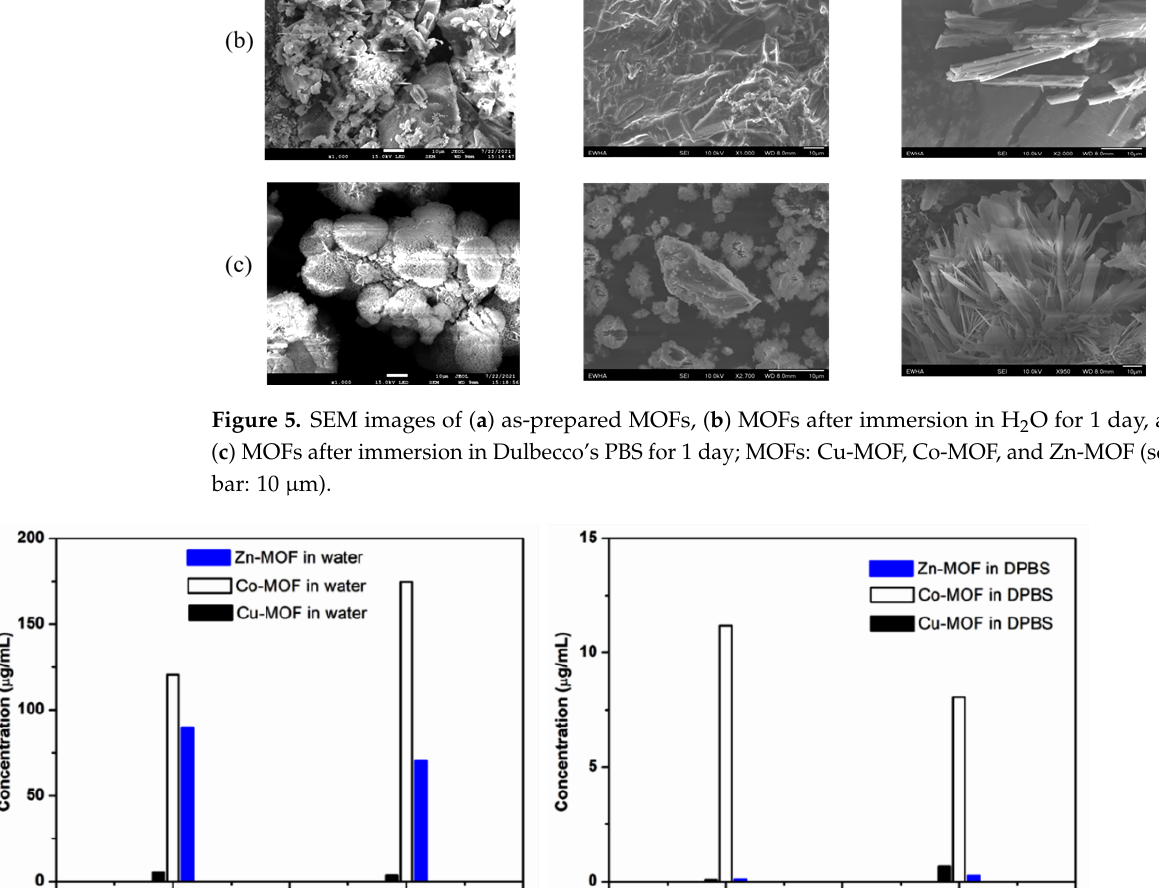
Figure 5. SEM images of ( a ) as-prepared MOFs, ( b ) MOFs after immersion in H 2 O for 1 day, and ( c ) MOFs after immersion in Dulbecco’s PBS for 1 day; MOFs: Cu-MOF, Co-MOF, and Zn-MOF (scale bar: 10 µm).